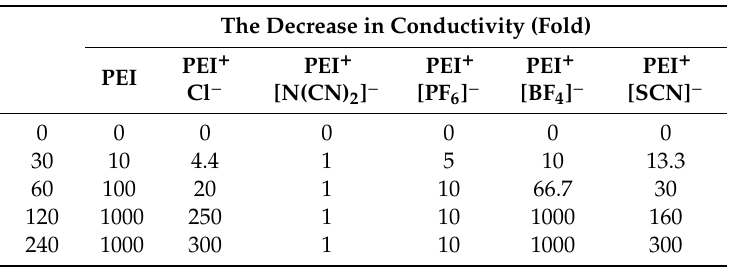
Table 2. The change in conductivities of bare polyethyleneimine (PEI) and IL forms of PANi containing composites after CO 2 gas exposure at various